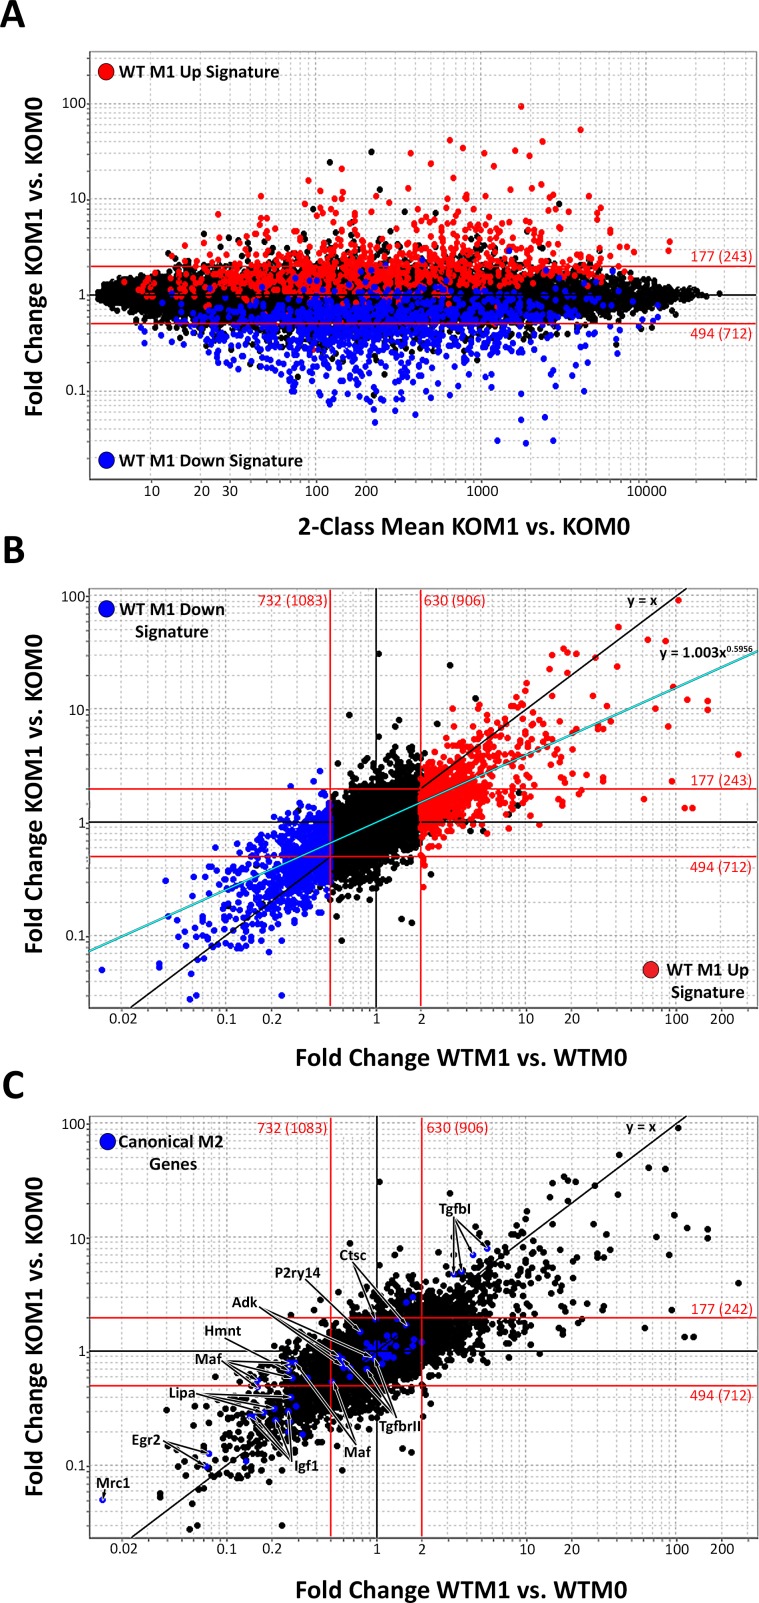
miR-155 is required for expression of the full classically activated macrophage signature.(A) Fold Change (FC) vs. Mean Expression Value (MEV) plot of knockout (KO) M1 vs. M0 microarray data, with highlighted classical wild-type (WT) M1 signature genes as defined in this study. Genes more than 2FC up-regulated in WT M1 macrophages (red genes in Fig 4A) are shown in red and genes more than 2FC down-regulated in WT M1 macrophages (blue genes in Fig 4A) are shown in blue. (B) WT M1/M0 FC vs. KO M1/M0 FC plot highlighting the WT M1 Up signature (in red) and WT M1 Down signature (in blue). The black line indicates the x = y trendline expected if all gene probes were similarly up- or down-regulated exactly the same in KO M1 and WT M1 macrophages (FC KO M1 vs KO M0 = FC WT M1 vs WT M0). The blue line indicates the power regression trendline that genes more closely adhered to, represented by y = 1.003x0.5956, R2 = 0.50052. (C) WT M1/M0 FC vs. KO M1/M0 FC plot highlighting classical M2 genes. Red lines represent a +/- 2FC cut-off. More than a single appearance of a gene symbol indicates different probes hybridizing the same gene transcript were present.